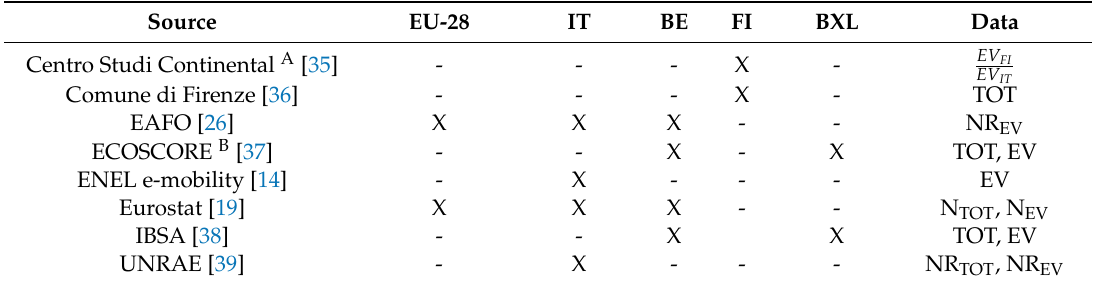
Table 2. Data sources for historical baseline characterization (FI = Florence, BXL =